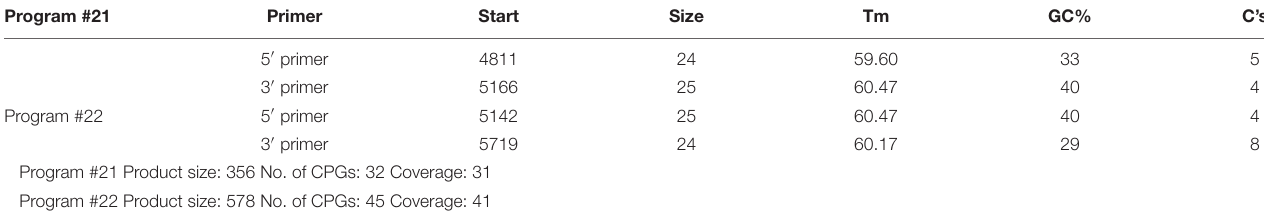
TABLE 1 | Primer design.